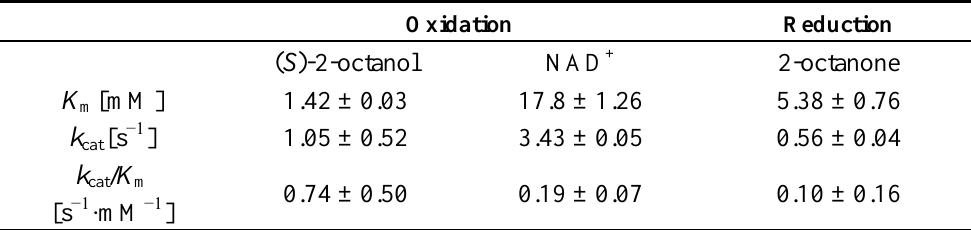
Table 3. Apparent kinetic parameters for Yl ADH2.